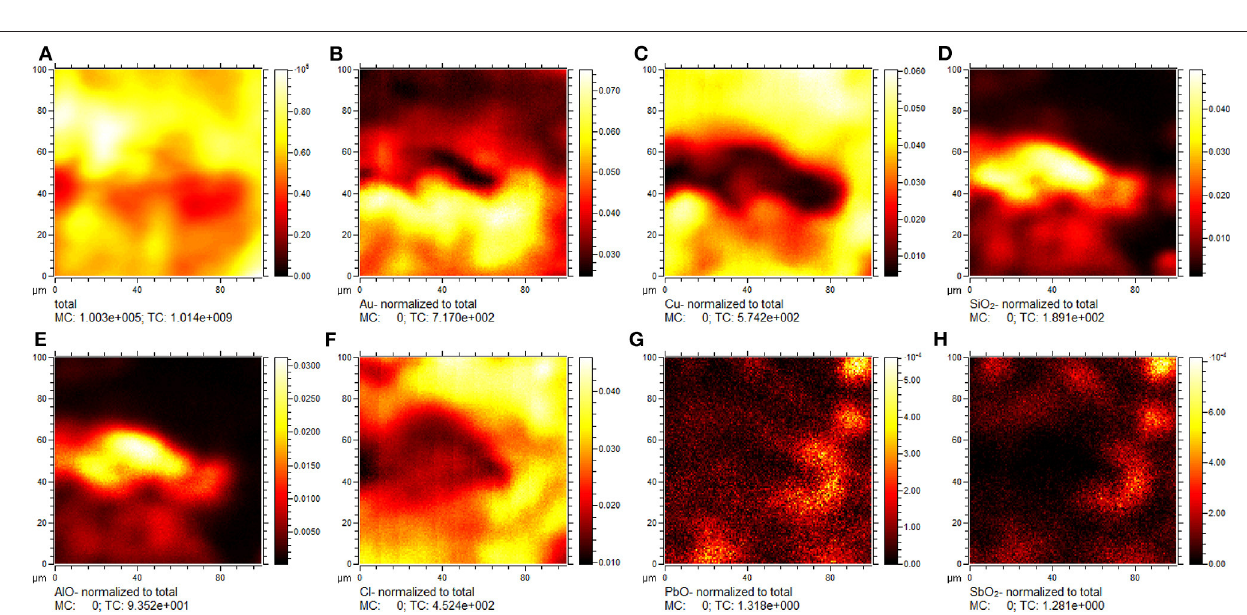
FIGURE 2 | ToF-SIMS negative ion spectrum of the analyzed volume: (A) mass fragmentation range from m/z 5 to 150; (B) mass fragmentation range from m/z 150 to 400.